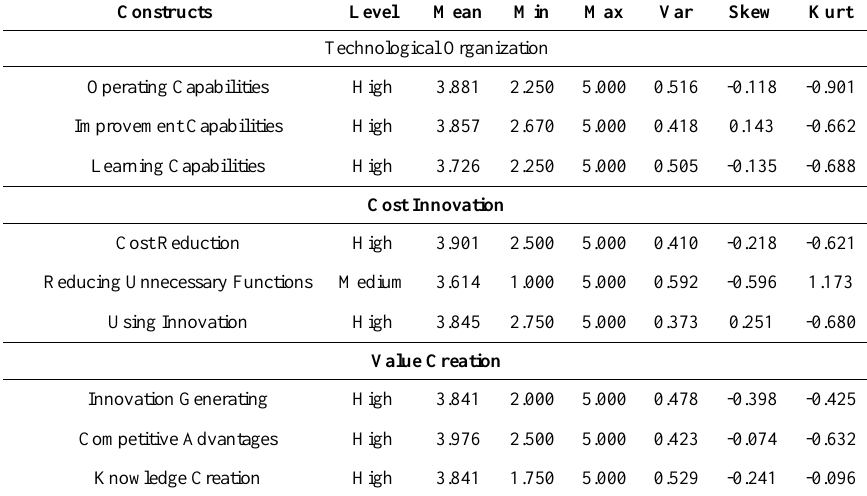
Table 1. Descriptive statistics of the samples